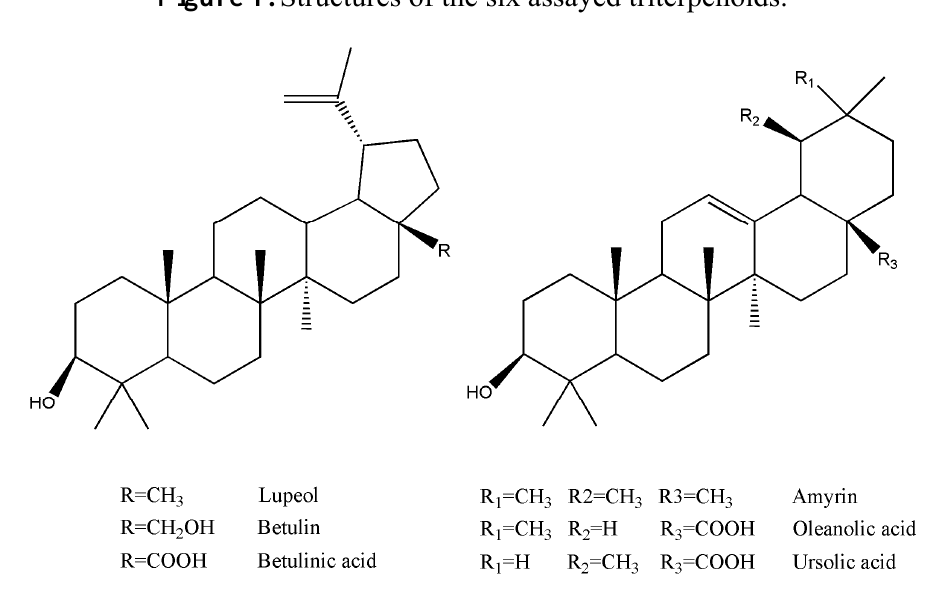
Figure 1. Structures of the six assayed